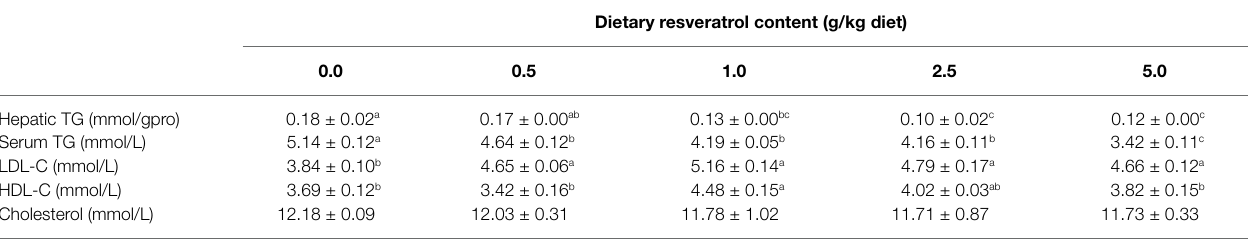
TABLE 2 | TG and lipoprotein content of largemouth bass fed diets with varying dietary RSV levels for 10 weeks * .